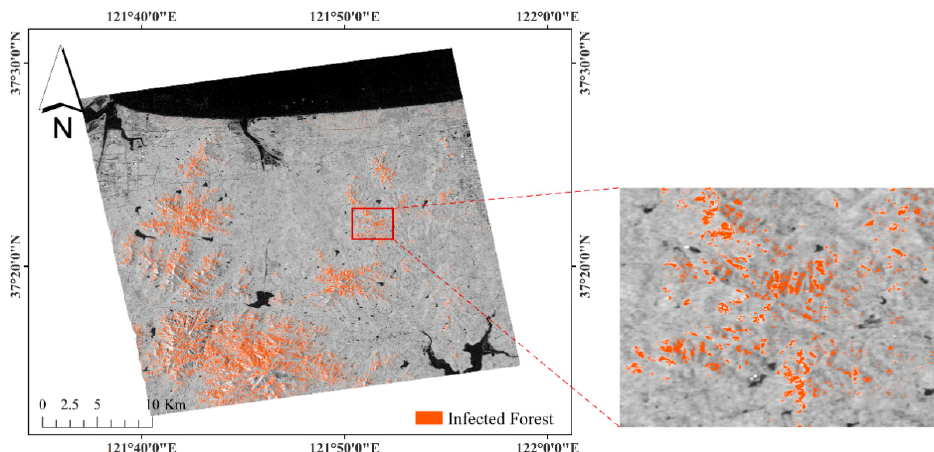
Figure 5. Predicted PWN infestation map from Radarsat-2 image through a random forest algo- rithm.